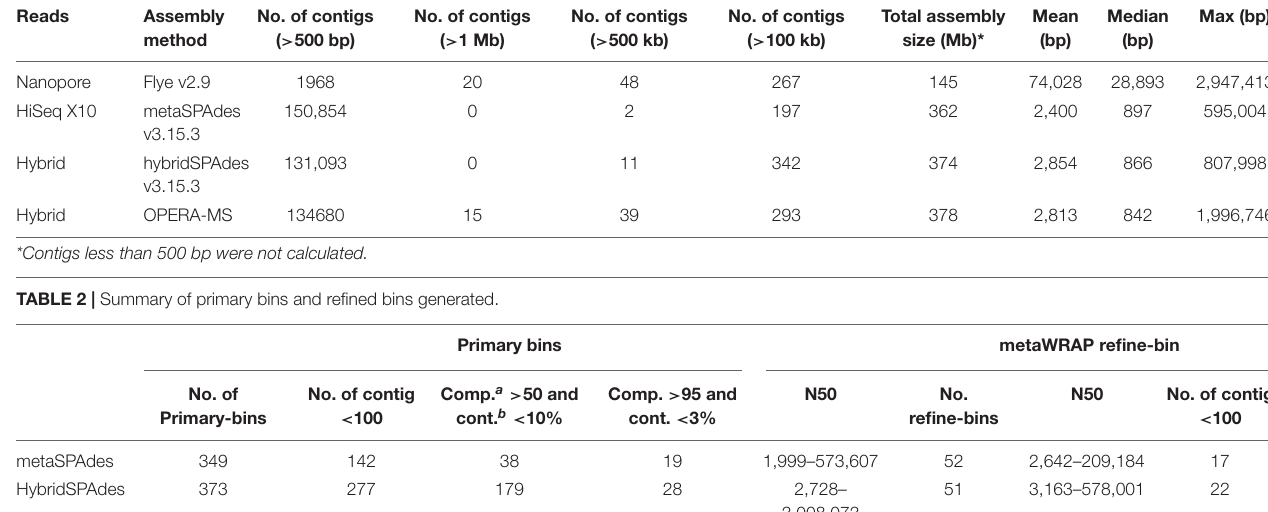
TABLE 1 | Assembly statistics of different assembly algorithms for the healthy human gut microbiome.